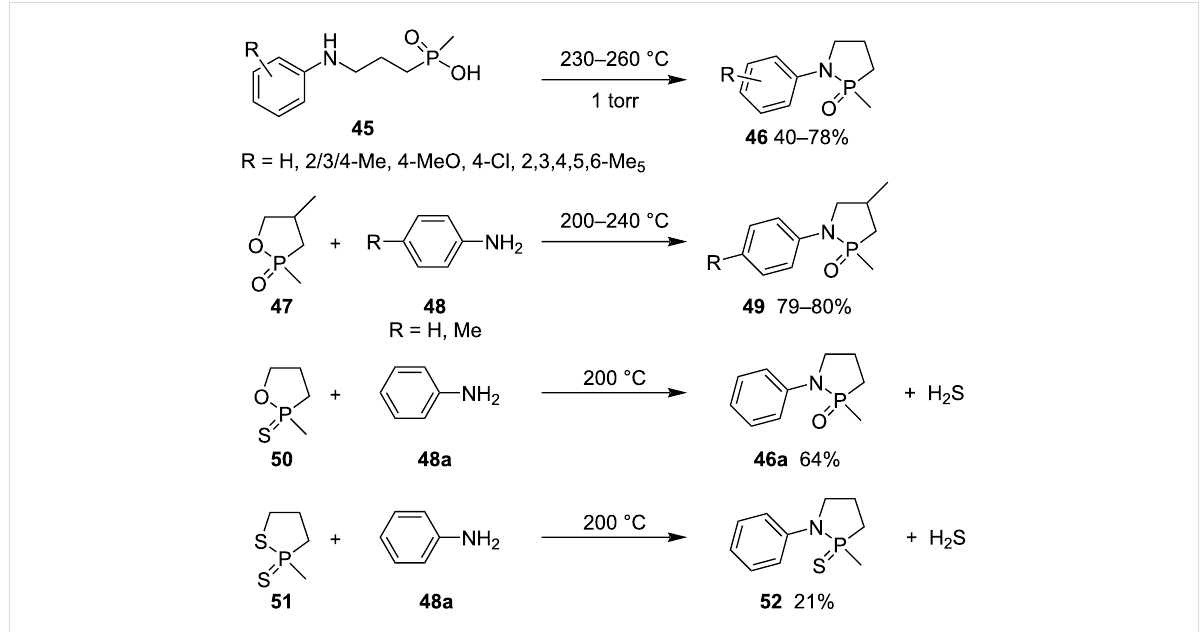
Scheme 8: Synthesis of azaphospholidine 2-oxides/sulfide from 1,2-oxaphospholane 2-oxides/sulfides and 1,2-thiaphospholane 2-sulfide with